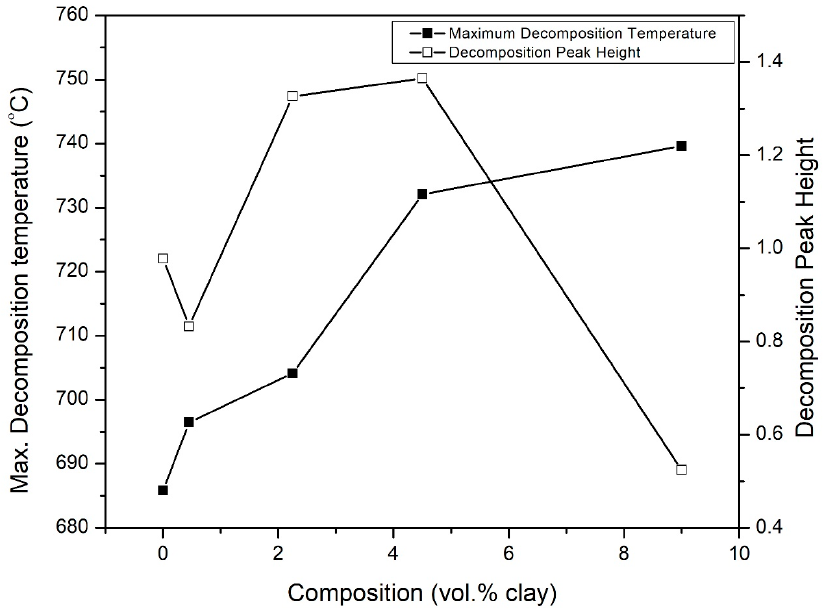
Figure 14. Variation of the decomposition peak height and the maximum decomposition temperature for the hybrid composites as a function of clay vo.%.